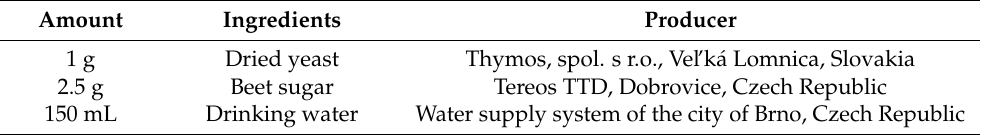
Table 1. Content of ingredients for tests monitoring the fermentation of baker’s yeast. Amount